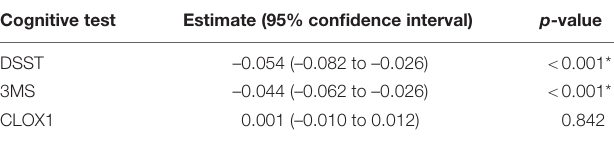
TABLE 3 | Multivariable linear mixed